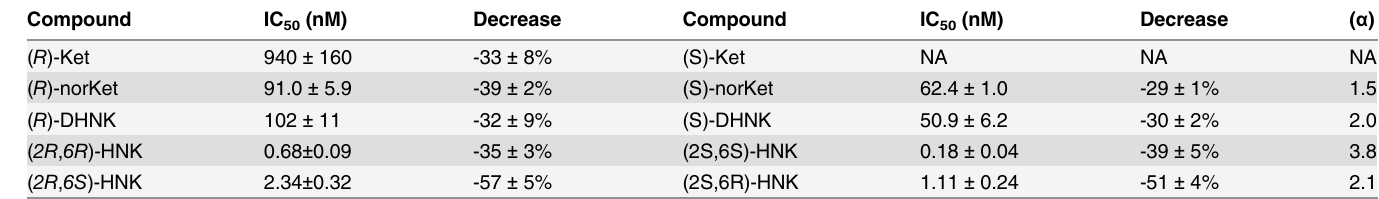
Table 1. The concentration-dependent decrease of intracellular D-Ser concentrations produced by incubation of PC-12 cells with the enantiomers of ketamine (Ket) and its major metabolites expressed as IC 50 values and percent (%) maximum decrease from vehicle-treated PC-12 cells. The effect of the configuration at the chiral centers on the magnitude of the IC 50 value represented as the enantioselectivity factor α is derived by IC 50 (2R isomer)/ IC 50 (2S isomer). The values for ( R )-Ket were obtained from [17] and ‘ NA ’ indicates that ( S )-Ket increases intracellular D-Ser concentrations [17]. Results are expressed as means ± SD, n = 3 independent experiments.